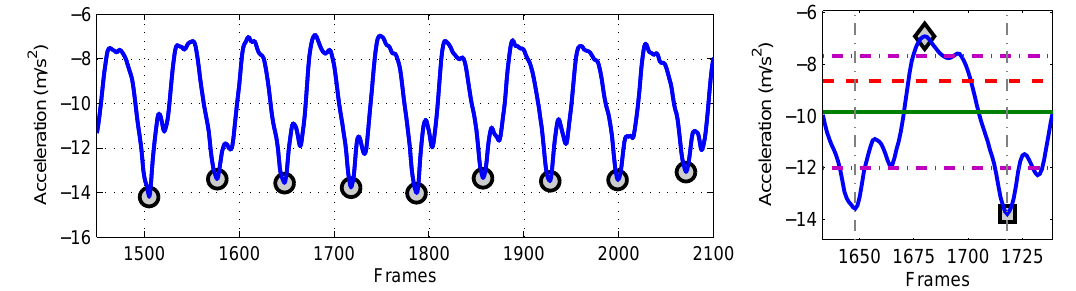
Figure 2. The pre-processed input signal from the x-axis of the IMU’s accelerometer attached to the lower back and an extracted single step are shown. In the left image, detected valleys are highlighted with (cid:13) . In the right image, a decomposed signal depicting a single step is shown between the vertical dash-dot lines (- · ). Some of the extracted features from the single step are: (1) square ( (cid:3) ): global minimum; (2) diamond ( (cid:5) ): global maximum; (3) solid line (–): mean; (4) horizontal dash-dot line (- · ): standard deviation; (5) dashed line (- -): root mean square; (6) between vertical dash-dot lines (- · ): length and duration.